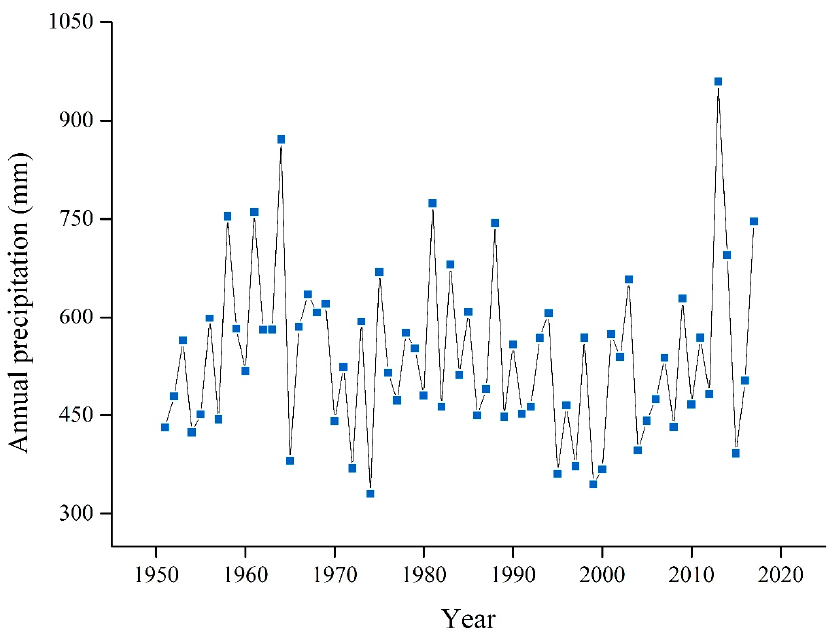
Figure 5. Annual precipitation from 1951 to 2019 at Baota Station. Table 1. The standard of rainfall levels.